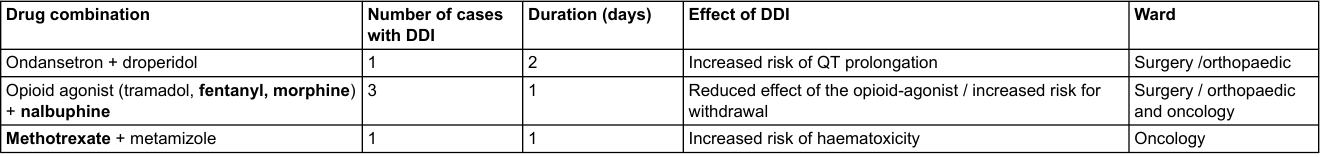
Table 2: Summary of the detected high-risk drug-drug interactions (DDIs, all pharmacodynamic interactions for drug combinations rated as “contraindicated by precaution”). Drug combination Number of cases Duration (days) Effect of DDI with DDI